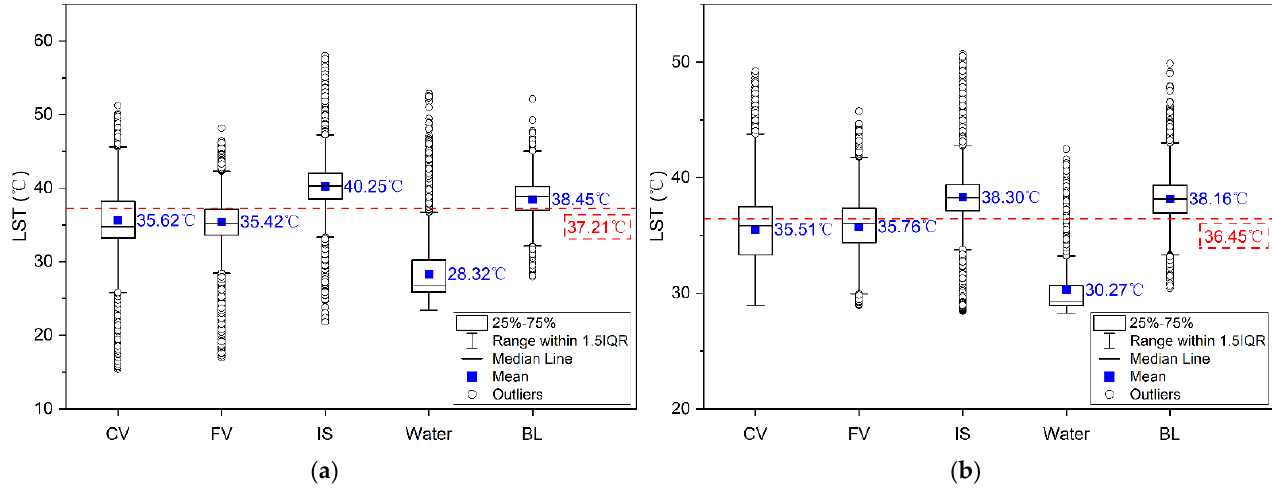
Figure 5. LST of land cover categories in ( a ) West Lake and its neighboring areas in Hangzhou, and ( b ) Xuanwu Lake and its neighboring areas in Nanjing (CV: coarse-textured vegetation; FV: fine-textured vegetation; IS: impervious surface; BL: bare lands; Water: water).